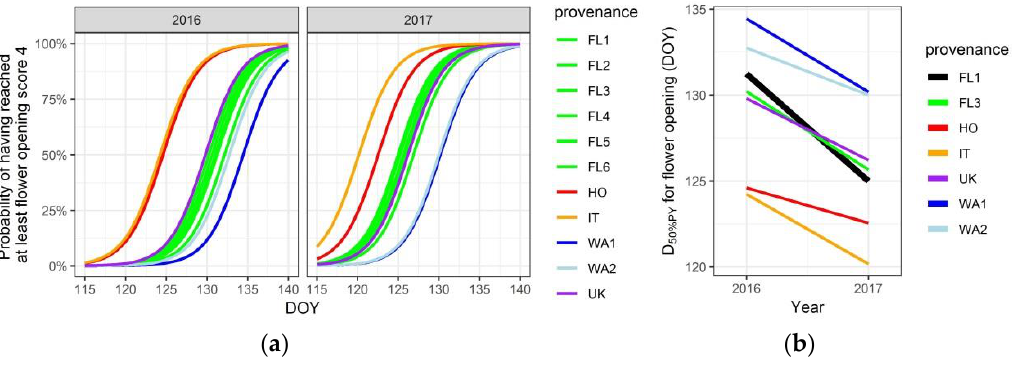
Figure 3. Modeled timing of flower opening for the different provenances in 2016 and 2017: ( a ) Modeled probability of having reached at least a flower opening score of four; ( b ) D 50% PY values for the provenances ( P ) with a significant interaction term in the model statistics, for the years ( Y ) 2016 and 2017. D 50% PY values indicate the modeled DOY when half of the plants of a provenance attain a flower opening score of at least four.